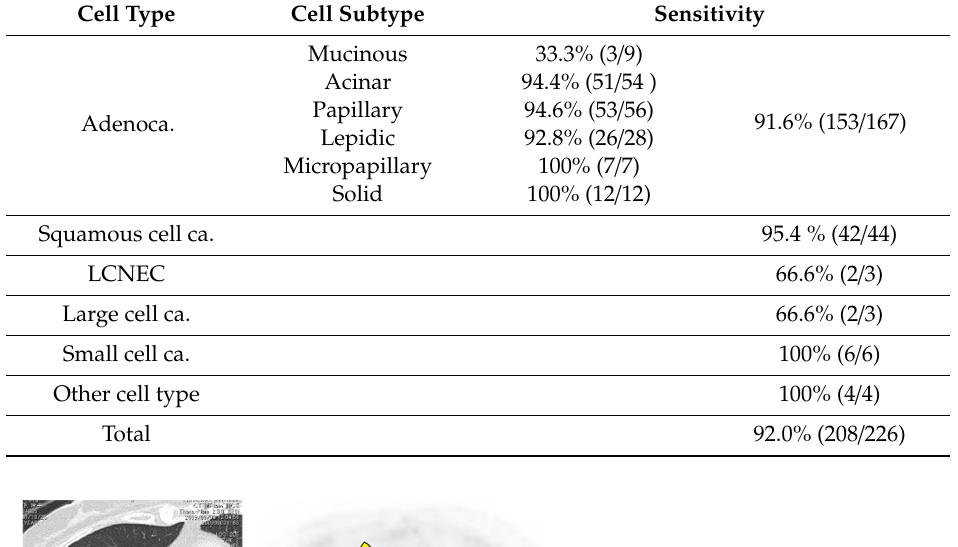
Table 1. Sensitivity of di ff usion-weighted imaging (DWI) for lung cancer.